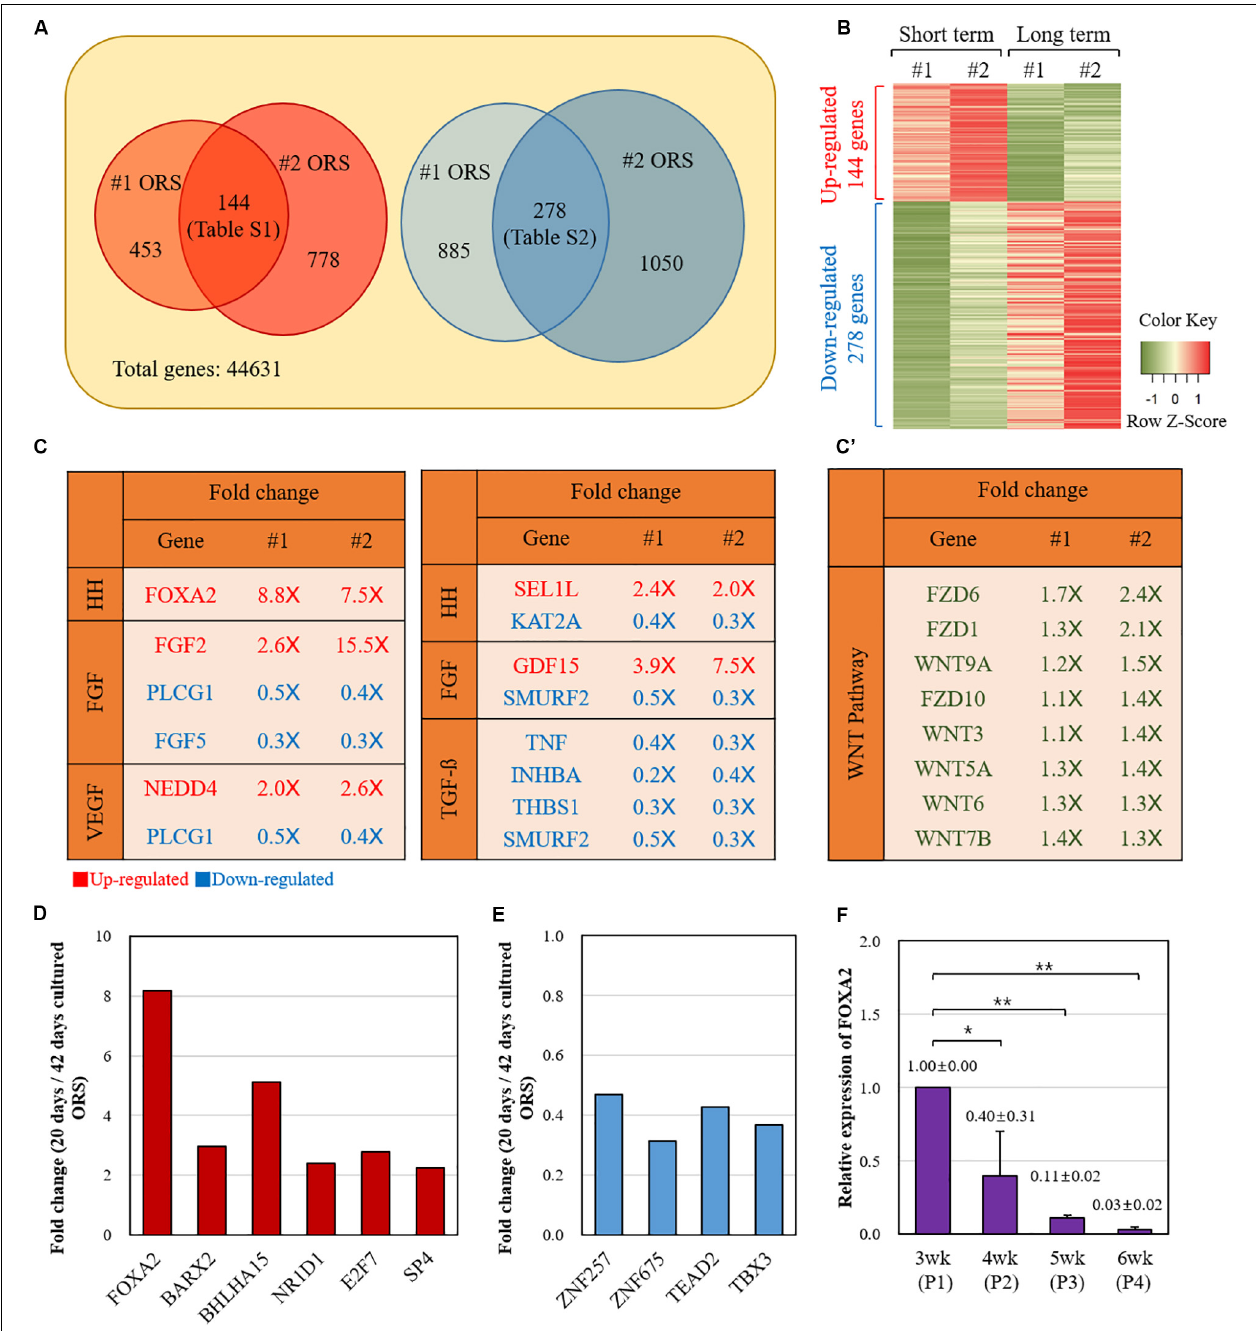
FIGURE 3 | Comparison of the gene expression profiles between the short-term and long-term cultured ORS cells. (A) Diagram of twofold up- and down-regulated genes in short-term cultured ORS cells. Two independent cell lines (#1 and #2) from two male patients (ages 50 and 64 years) were cultured for 20 days and 42 days, and microarray analysis was performed with transcripts derived from those cells. The number of genes with a more than twofold increase and decrease in the short-term cultured ORS cells are shown on the left and right, respectively. A total of 144 genes had a more than twofold increase in both short-term cultured ORS cells (listed in Supplementary Table S1 ), and 278 genes had a more than twofold decrease in both short-term cultured ORS cells (listed in Supplementary Table S2 ). (B) Heat map of differentially expressed genes (DEGs). The up-regulated genes were shown in red color and down-regulated genes in green color. (C) List of genes related to the skin signaling pathways from twofold up-regulated (2.0 × ) and down-regulated (0.5 × ) genes. Genes were selected based on gene-set enrichment analysis (GSEA) information in each pathway (HH, FGF, VEGF, Notch, BMP, and TGF-b). (C’) List of up-regulated Wnts and their receptor (FZD) among WNT signaling pathway. (D) Relative fold changes of six up-regulated transcription factors. (E) Relative fold changes of four down-regulated transcription factors. (F) Relative levels of FOXA2 expression of ORS cells in various cultivation periods (3, 4, 5, and 6 weeks). Data are expressed as means ± standard deviation of three different ORS cell lines from three male patients (ages 33, 38, and 67